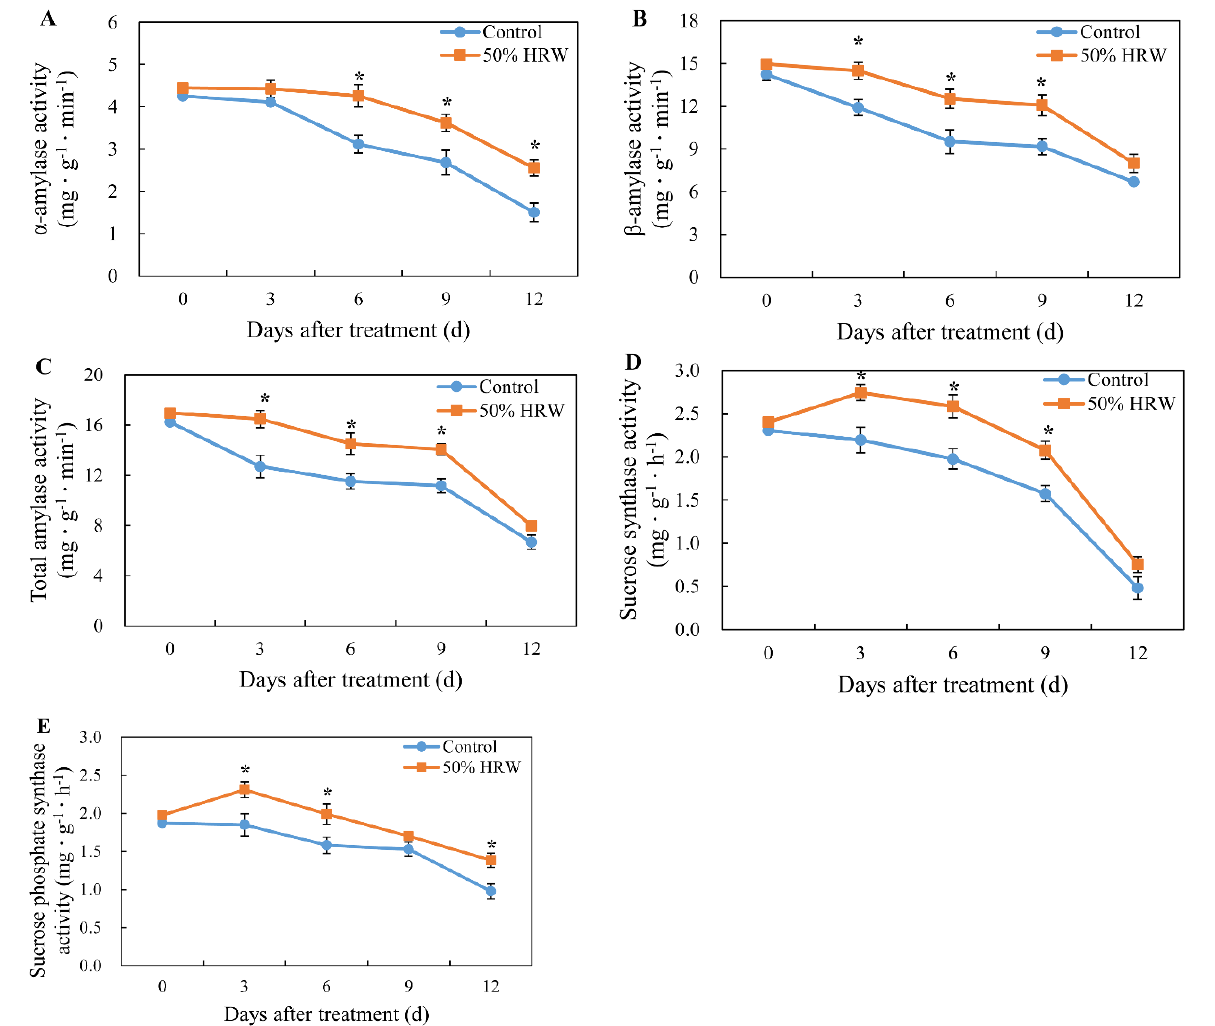
Figure 6. Changes in sugar-metabolizing enzyme activity in Lanzhou lily scales with or without 50% HRW treatment during storage at room temperature for 12 days. ( A ) α -amylase activity; ( B ) β - amylase activity; ( C ) Total amylase activity; ( D ) Sucrose synthase activity; ( E ) Sucrose phosphate synthase activity. Values are the mean ± SE of three independent experiments. The asterisks denote T -test significance between the control and 50% HRW treatment on the same day: * p < 0.05. HRW: hydrogen-rich water.